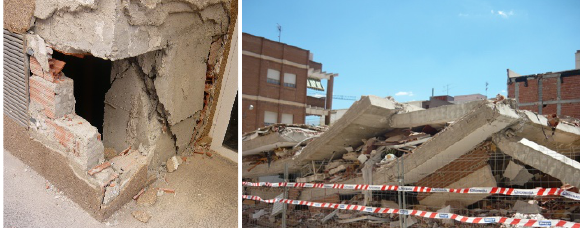
Figure 2. Buildings with short columns after Lorca 11th